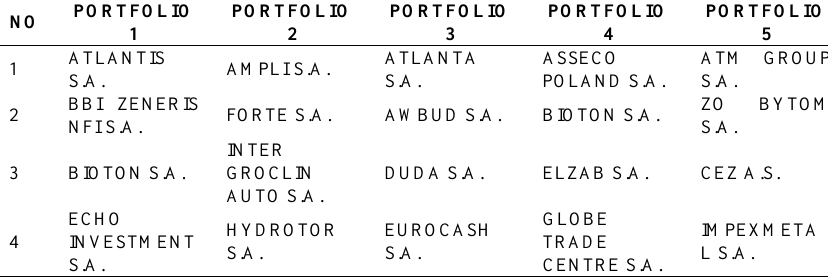
Table 9. Companies, which shares were included in the study for